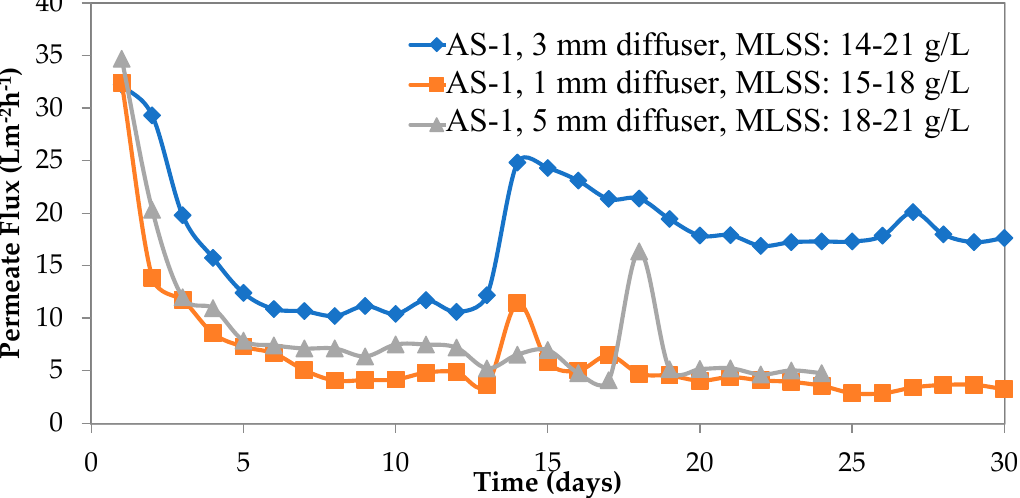
Figure 7. Comparison of the tests with di ff erent di ff user hole diameters (AS-1, MLSS: 15–21 g/L).